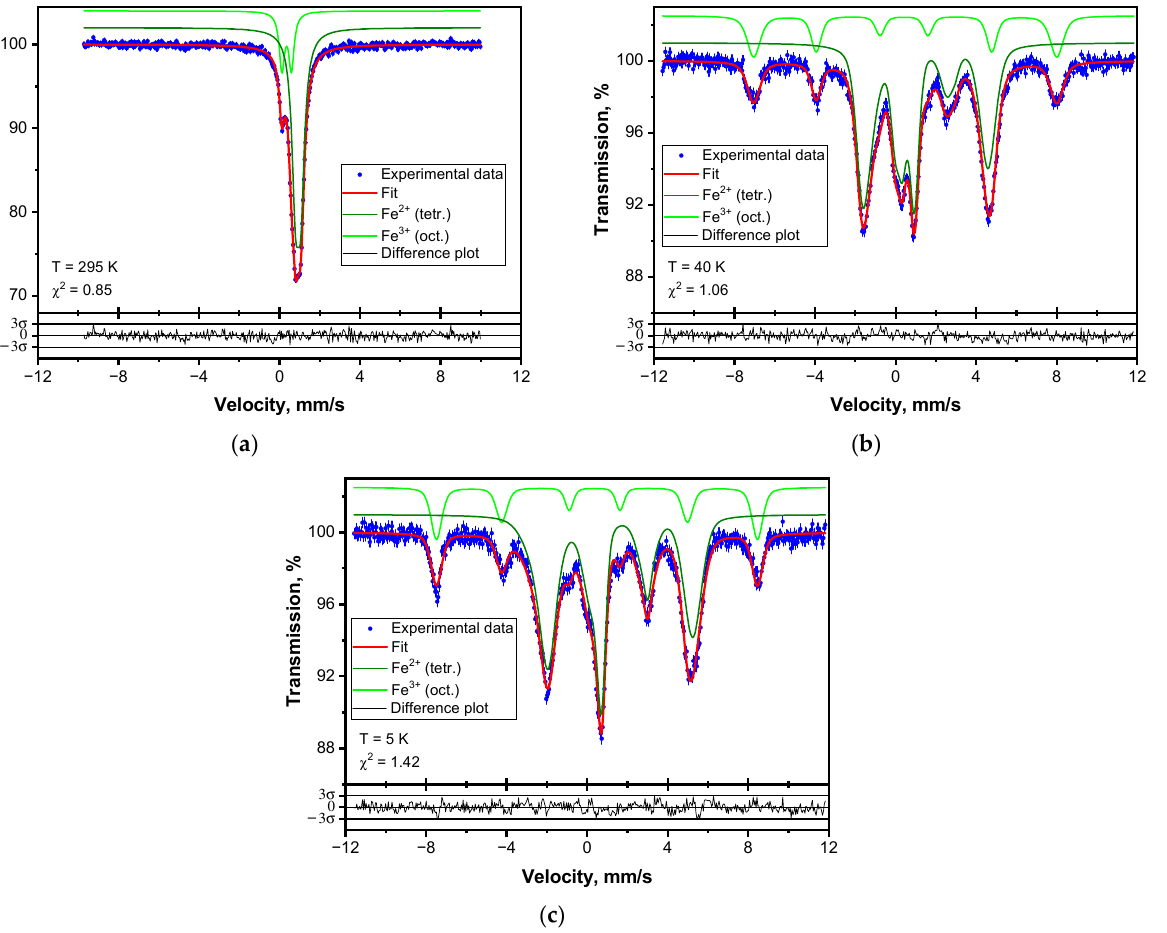
Figure 5. Mössbauer spectra of Fe 2+ Cr 3+1.75 Fe 3+0.25 O 4 sample recorded at ( a )—295 K, ( b )—40 K, and ( c )—5 K, and their fitting model curves. The residuals between experimental data and the fitting curves are shown at the bo tt om in the units of the statistical error.